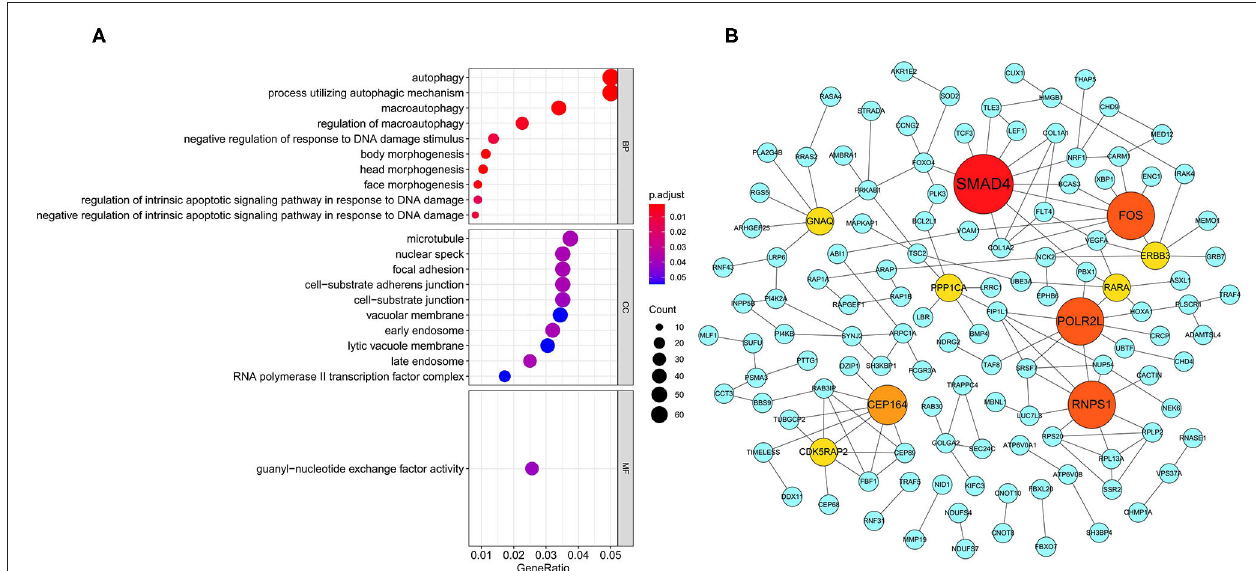
FIGURE 3 | GO enrichment analysis and gene interaction network. (A) GO enrichment analysis (BP/CC/MF) of the parent genes from survival-related AS events. (B) Gene interaction network of the most significantly survival-related genes. GO, Gene Ontology; BP, biological process; CC, cellular component; MF, molecular function.